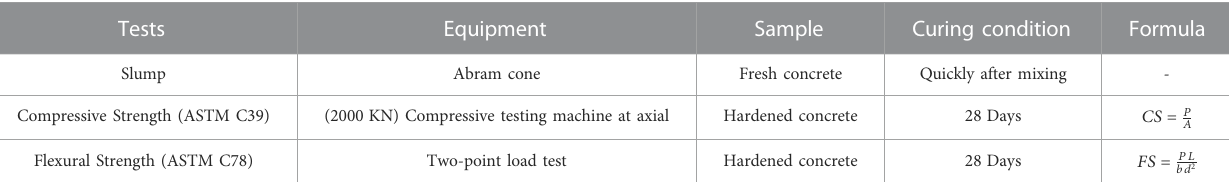
TABLE 2 Material testing mechanisms.